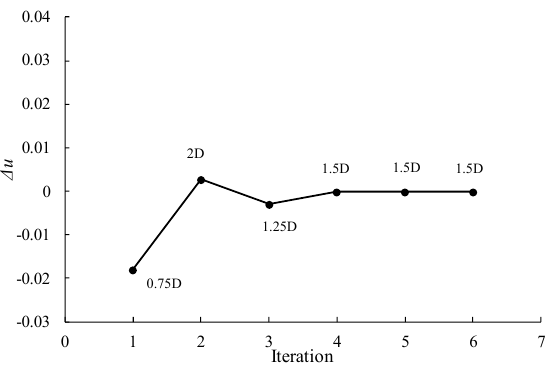
Figure 6. Results from the iterative wake length procedure applied to a circular cylinder.